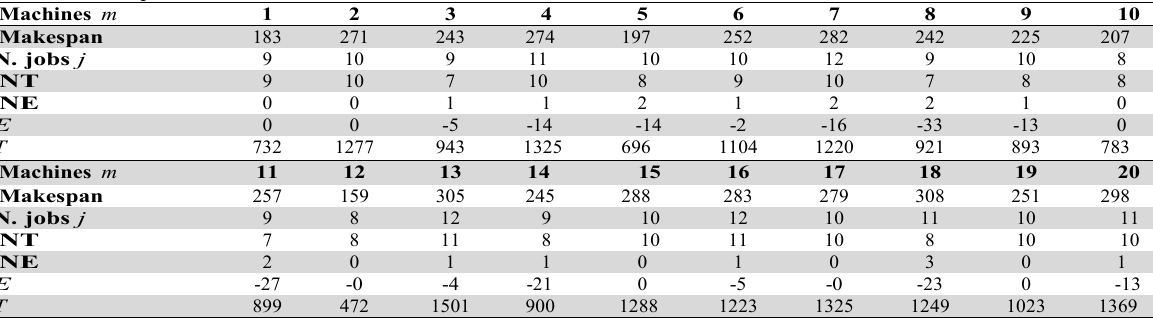
Results of the optimum solution chosen in the third scenario. Machines